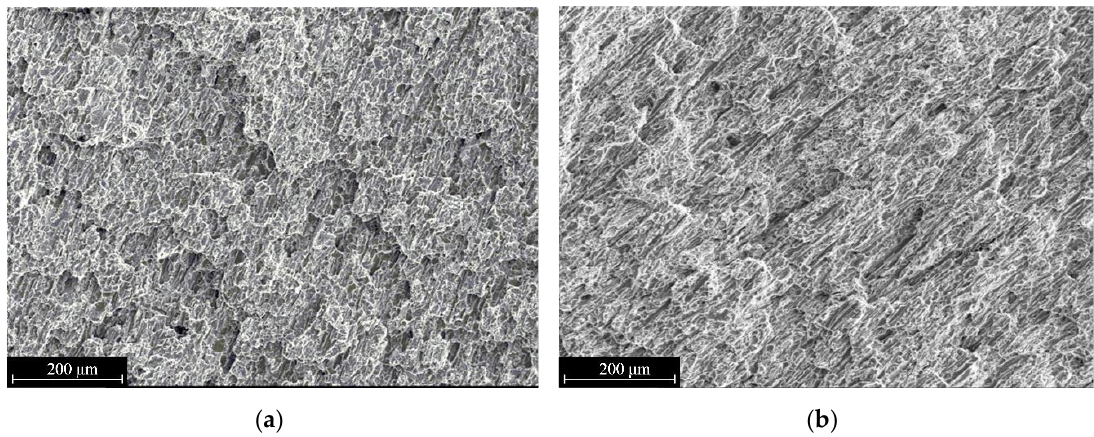
Figure 19. General views of the fracture surfaces of dissimilar welded joints of (Ti-TiB)–T110 series samples at the temperature 20 °С, ×100: ( a ) plasticity 1.2%; ( b ) plasticity 4.9%.